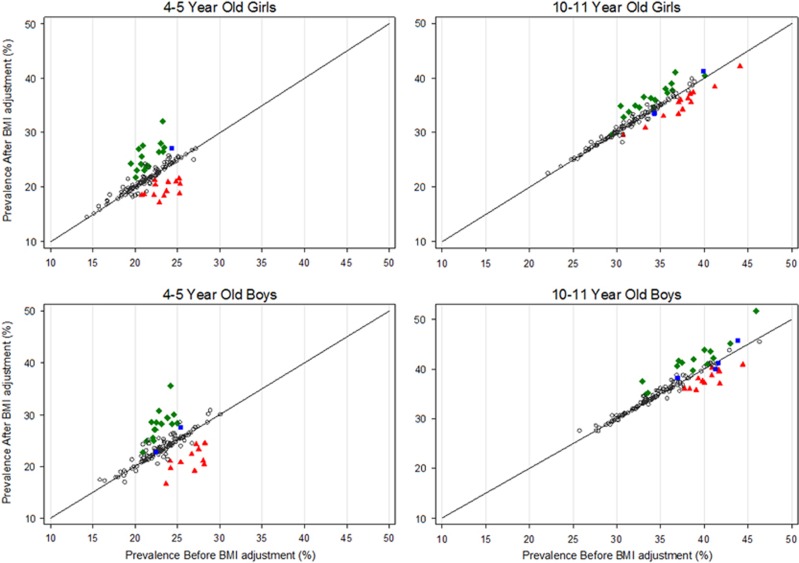
Correlation of prevalences of overweight-obesity in local authorities before and after BMI adjustments by age–sex group in the national child measurement programme (2012–13). Local authorities are colour coded by ethnic composition. Legend: open circles=South Asian & Blacks<20%, green diamond=South Asian⩾20% & Blacks<20%, red triangle=Blacks⩾20% & South Asian<20%, blue square=South Asian & Blacks⩾20% Based on the overweight-obesity population thresholds: overweight-obese: ⩾85th centile Excluding areas with potential data quality issues and areas with <1000 individuals.